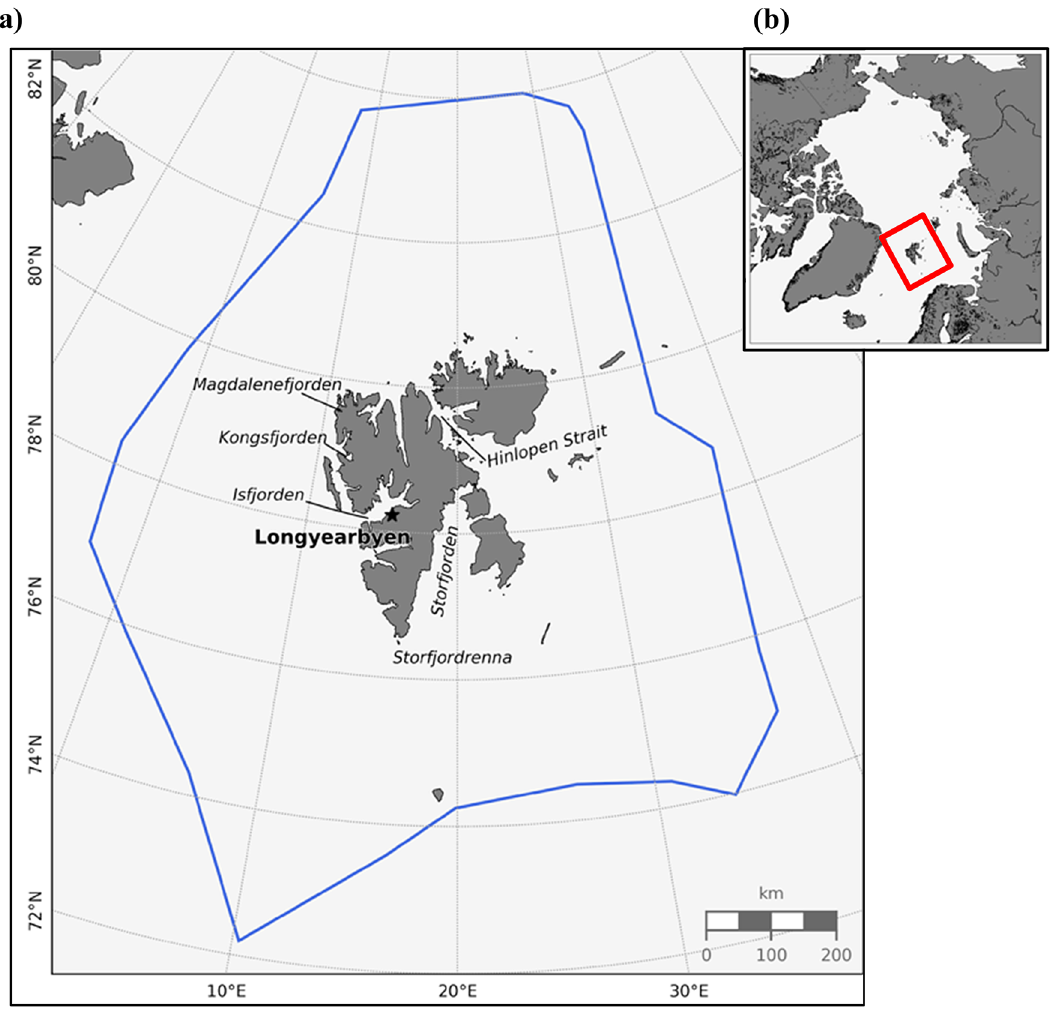
Figure 1. ( a ) Map of Svalbard with main administrative settlement Longyearbyen and relevant geographical areas where navigation takes place. The blue line delimits the boundaries of the SFPZ. ( b ) Location of the archipelago in the Arctic. Figures generated with python 3.7.x (https ://www.pytho